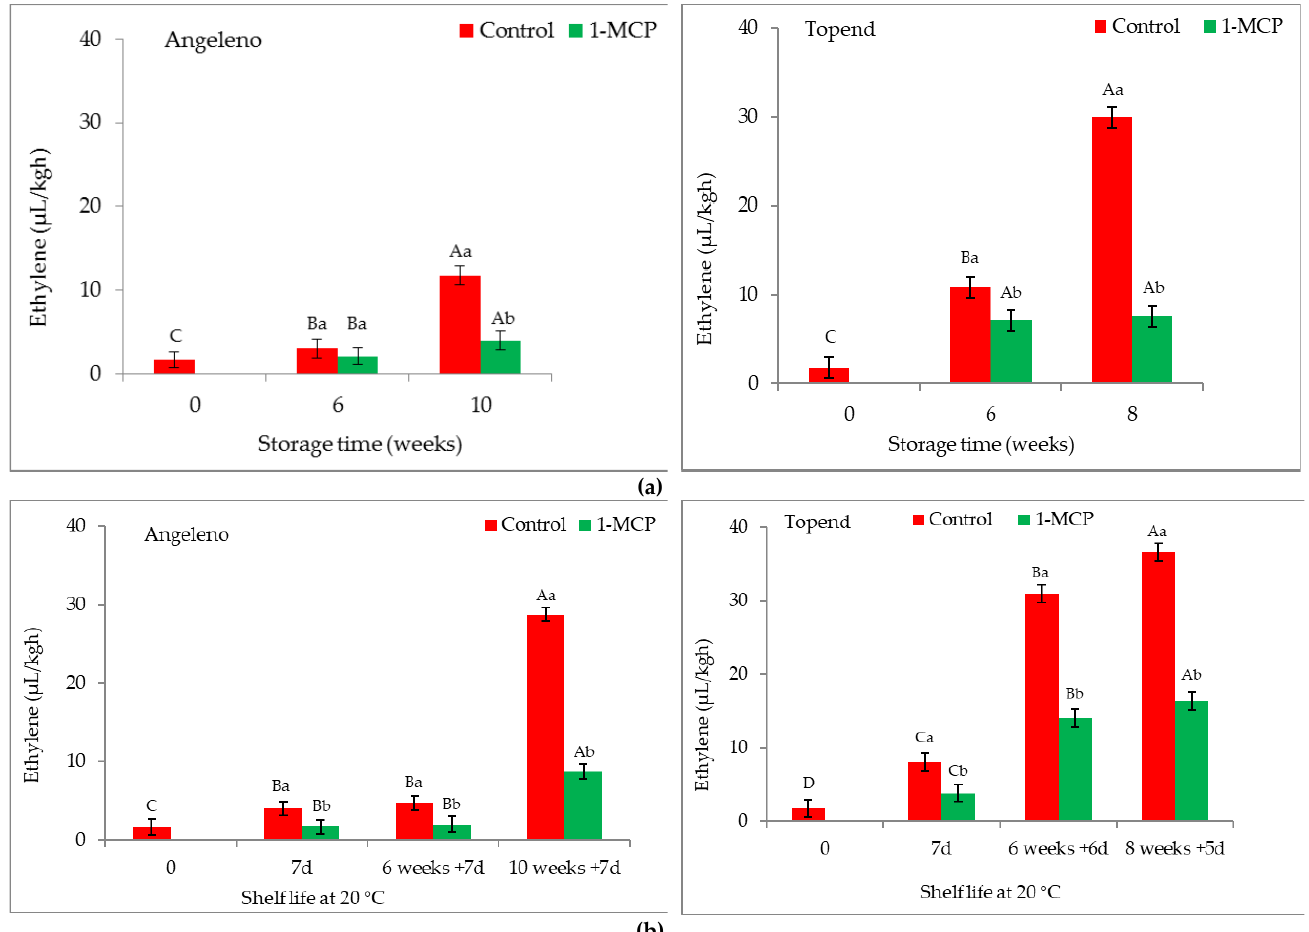
Figure 3. Ethylene production of plum during cold storage at 1 °C ( a ) and subsequent shelf-life storage at 20 °C ( b ). Presented values are mean ± SD. Upper case is for the comparisons of time (Tukey’s, p < 0.05). Lower case is for the comparisons of treatment (Tukey’s, p < 0.05).